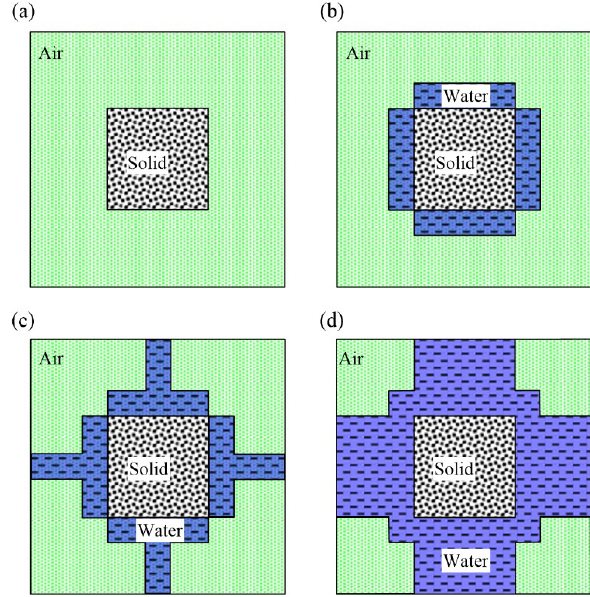
Figure 4 : Periodic cell according to the Gori model (Gori, 1983):